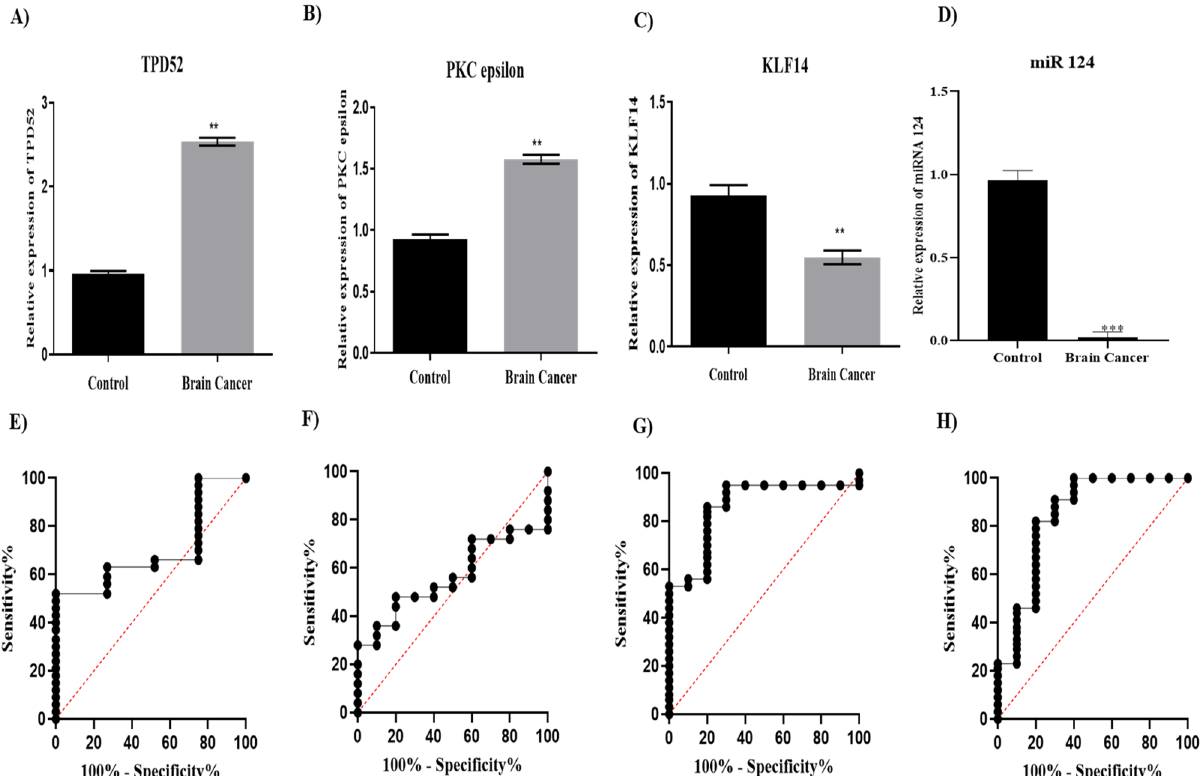
Figure 1. Expression and diagnostic significance of TPD52, PKCε, KLF14 and miRNA 124. Expression of ( A ) TPD52 ( B ) PKCε ( C ) KLF14 and ( D ) miR-124 in brain tumor patients compared to healthy controls. There is up-regulated expression of TPD52, and PKCε ( P = 0.0015, P = 0.0046 respectively) and down-regulated expression of KLF14 and miRNA124 ( P = 0.0025, P = 0.0010 respectively) in brain tumor patients compared to healthy controls. Representative data were presented as mean ± SEM of triplicate experiments and **refers to P value less than 0.05 and ***refers to P value less than or equal to 0.001. Statistical significance was measured by two-way ANOVA. ROC curve for TPD52, PKCε, KLF14 and miR-124 predicted high risk for brain tumor. Area under the ROC curve (AUC) for ( E ) TPD 52 was 0.69 and 95% confidence interval (CI) was 0.6236 to 0.7758. AUC for ( F ) PKCε was 0.564 and 95% CI was 0.4804 to 0.6476. AUC for ( G ) KLF14 was 0.86 and 95% CI was 0.8057 to 0.9143. AUC for ( H ) miR-124 was 0.8420 and 95% CI was 0.7858 to